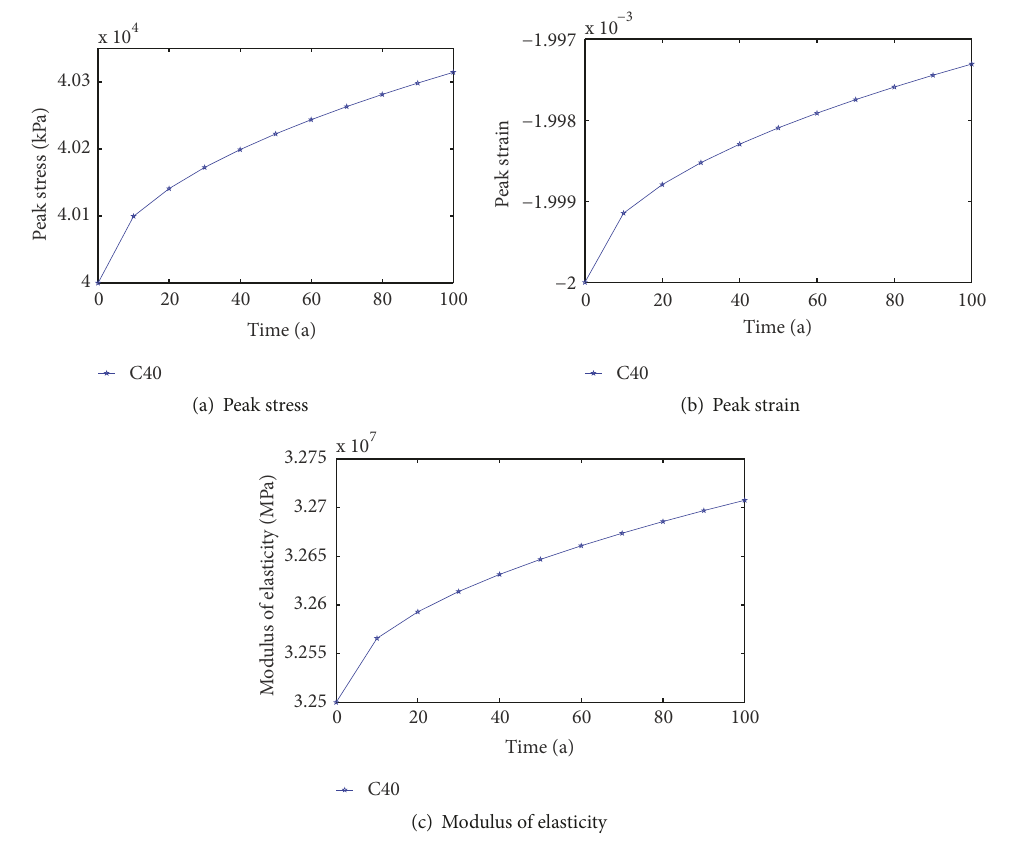
(c) Modulus of elasticity Figure 5: Mechanical property of C40